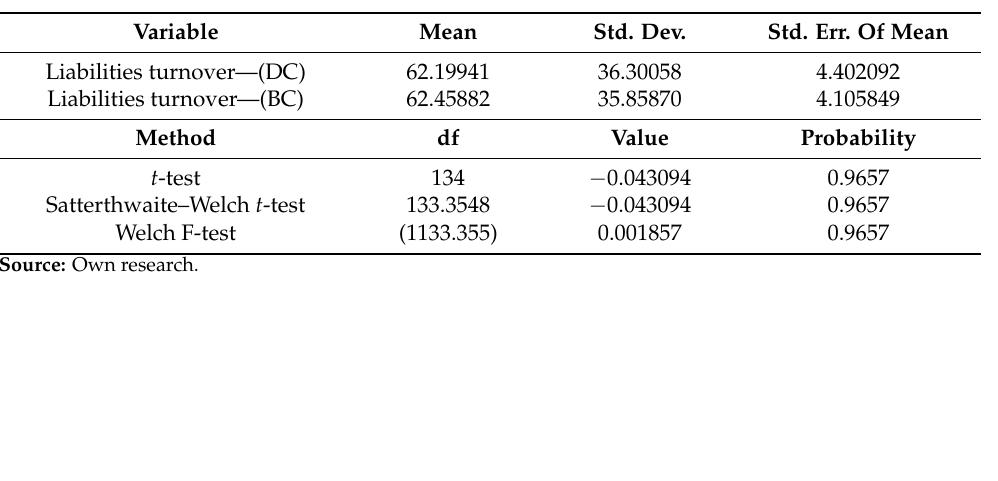
Table 8. The result of short-term liabilities